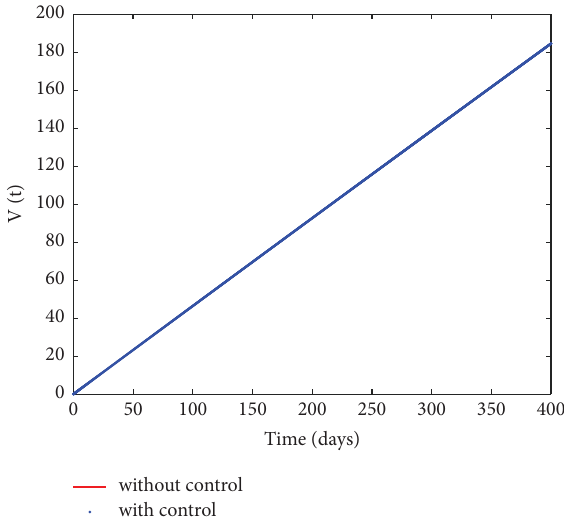
Figure 14: Behaviour of the immune individuals with and without the control.